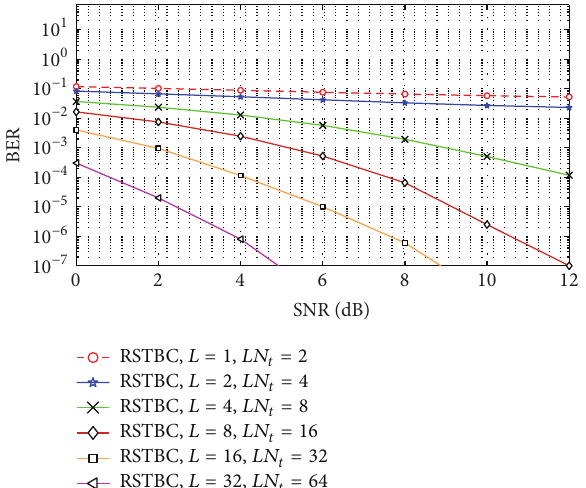
Figure 7: BER of RSTBC for massive SU-MIMO up to 𝐿𝑁 𝑡 = 64 with 16-QAM for 25%-loss rate.